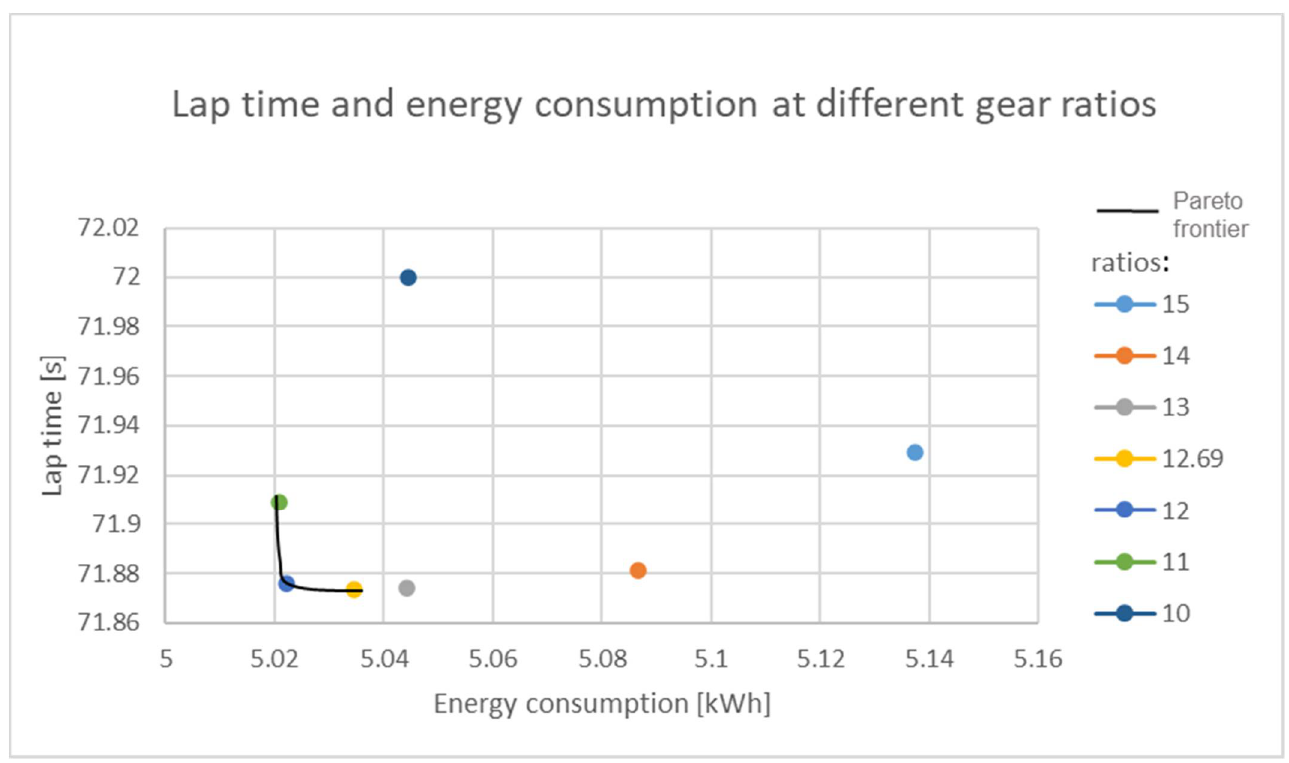
Figure 10. Full factorial study and resulting Pareto frontier to minimize the energy consumption and the reached lap time of the race car .